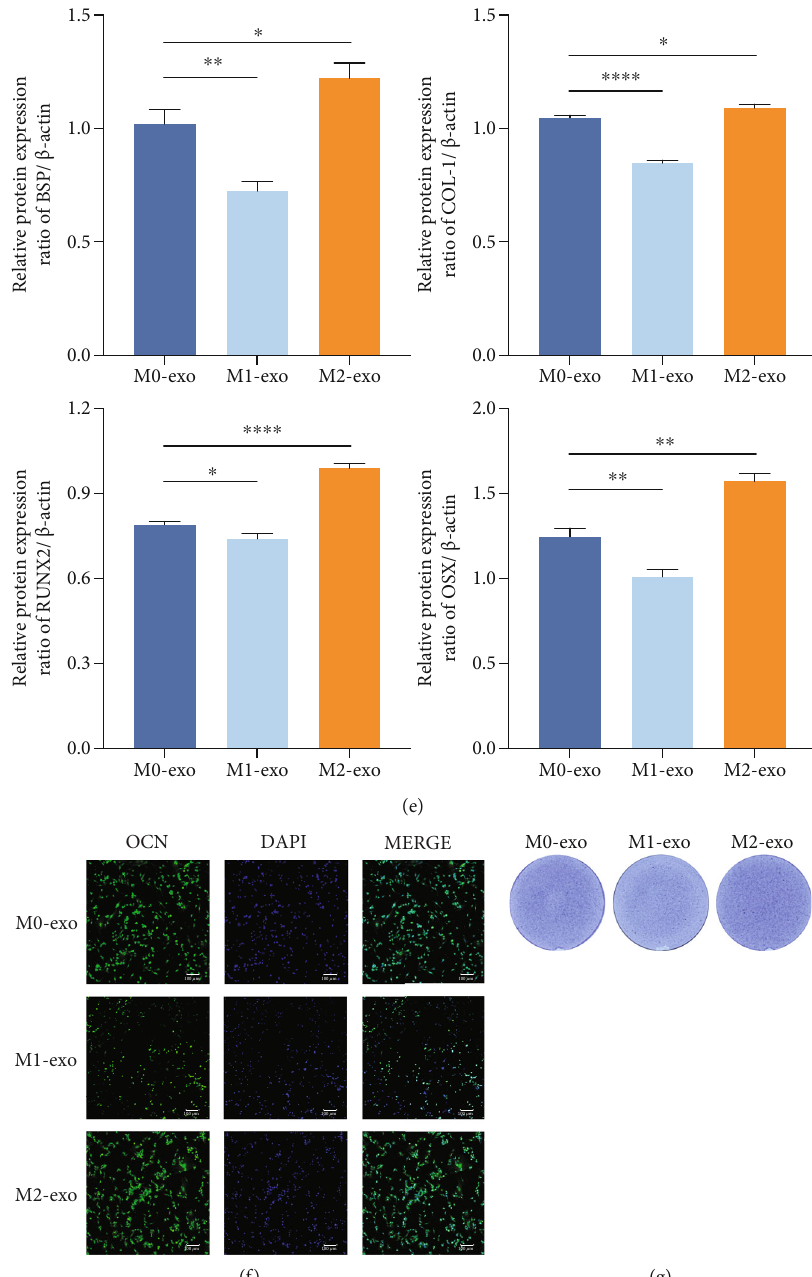
Figure 4: Macrophages with di ff erent polarization phenotypes in fl uenced cementoblast mineralization through exosomes. (a) Representative pictures of the exosomes observed by transmission electron microscopy. White arrows indicate the representative exosomes. Scale bars: 100 nm. (b) Representative chemiluminescent images of ALIX, CD63, and GM130 western blots from exosomes. (c) The mRNA expression levels of BSP, COL-1, RUNX2, OSX, and PTPLA in cementoblasts after a 3-day culture with exosomes from M0, M1, or M2 (referred to as M0-exo, M1-exo, and M2-exo). (d) Representative chemiluminescent images of BSP, COL-1, RUNX2, and OSX western blots from cementoblasts after a 3-day culture with exosomes from M0, M1, or M2 (referred to as M0-exo, M1-exo, and M2-exo). (e) Western blot analysis of BSP, COL-1, RUNX2, and OSX. The gray value was calibrated using β -actin. ∗ P < 0 : 05 , ∗∗ P < 0 : 01 , ∗∗∗ P < 0 : 001 , and ∗∗∗∗ P < 0 : 0001 . (f) Confocal microscopy of OCN with DAPI counterstaining in cementoblasts after a 3-day culture with exosomes from M0, M1, or M2 (referred to as M0-exo, M1-exo, and M2-exo). Scale bars: 100 μ m. (g) ALP staining of cementoblasts after a 5-day culture with exosomes from M0, M1, or M2(referred to as M0-exo, M1-exo, and